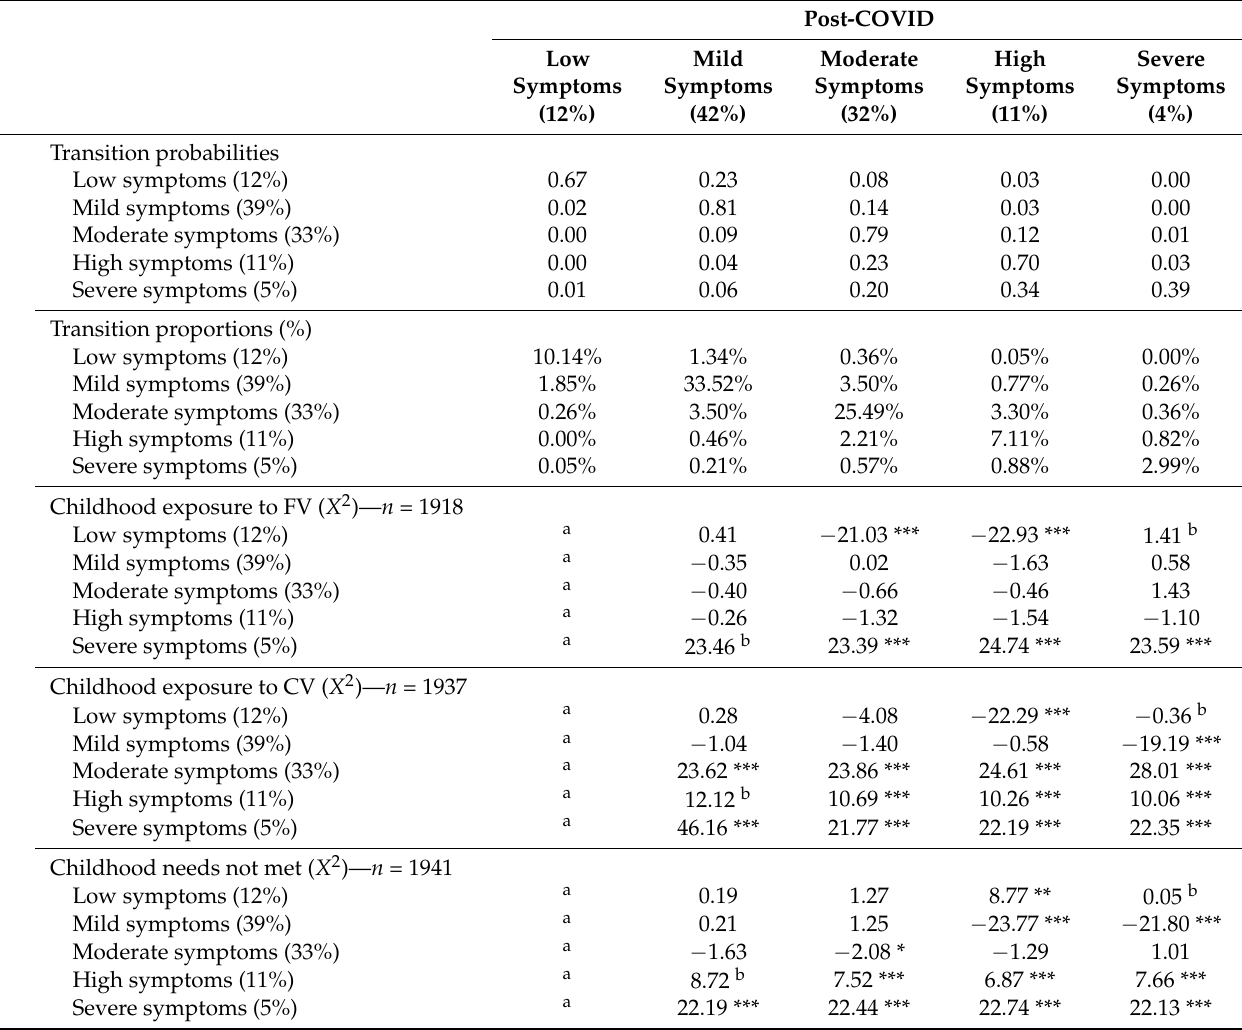
Table 5. Transition probabilities and logistic regression coefficients for the effects of predictors on